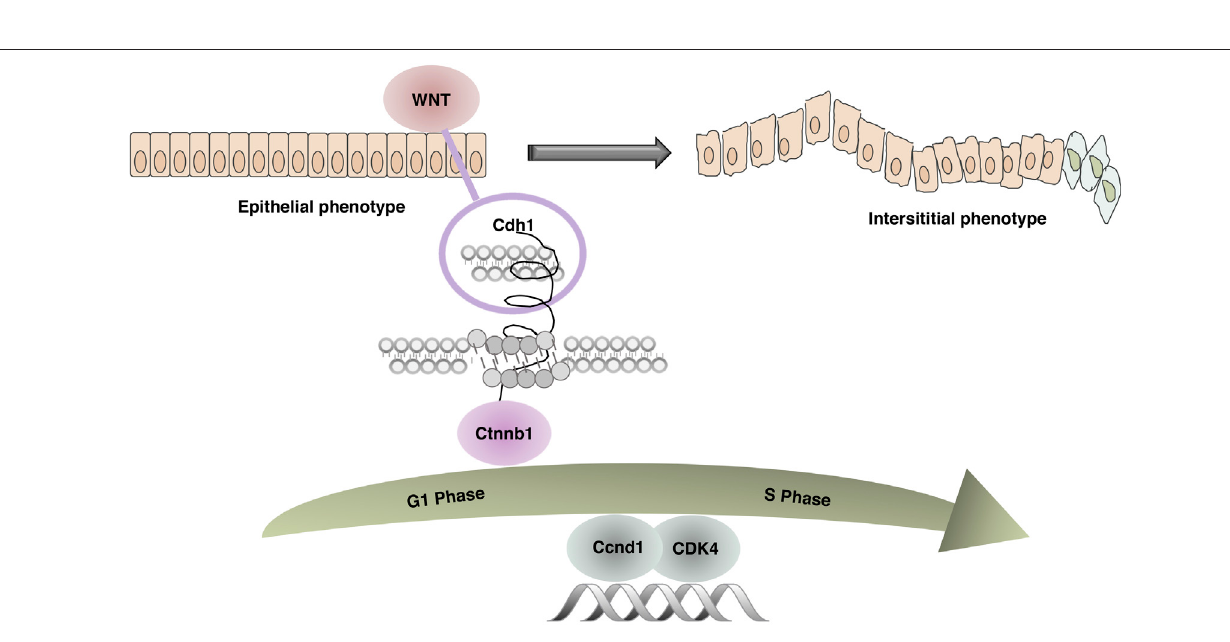
Frontiers in Pharmacology |